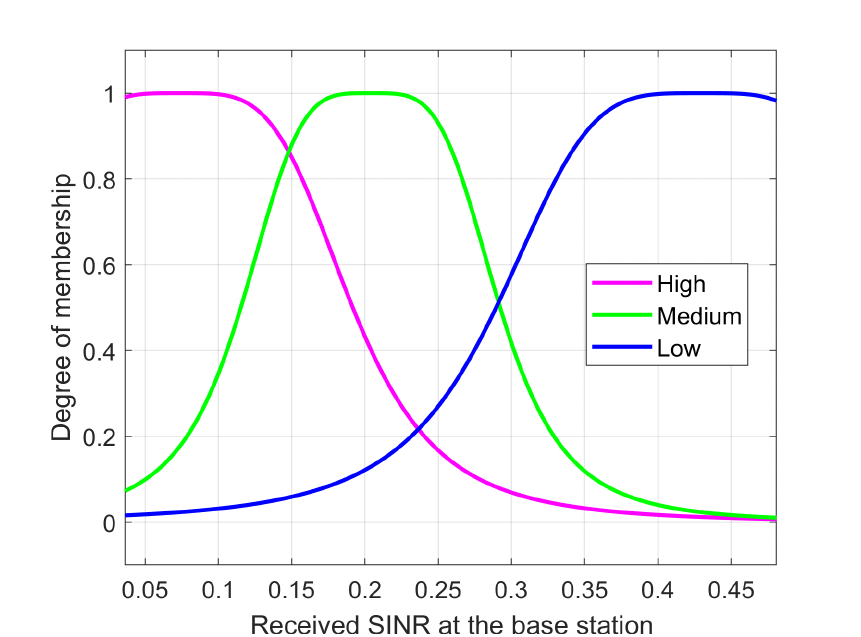
Figure 6. Input (received SINR at the BS) membership function.